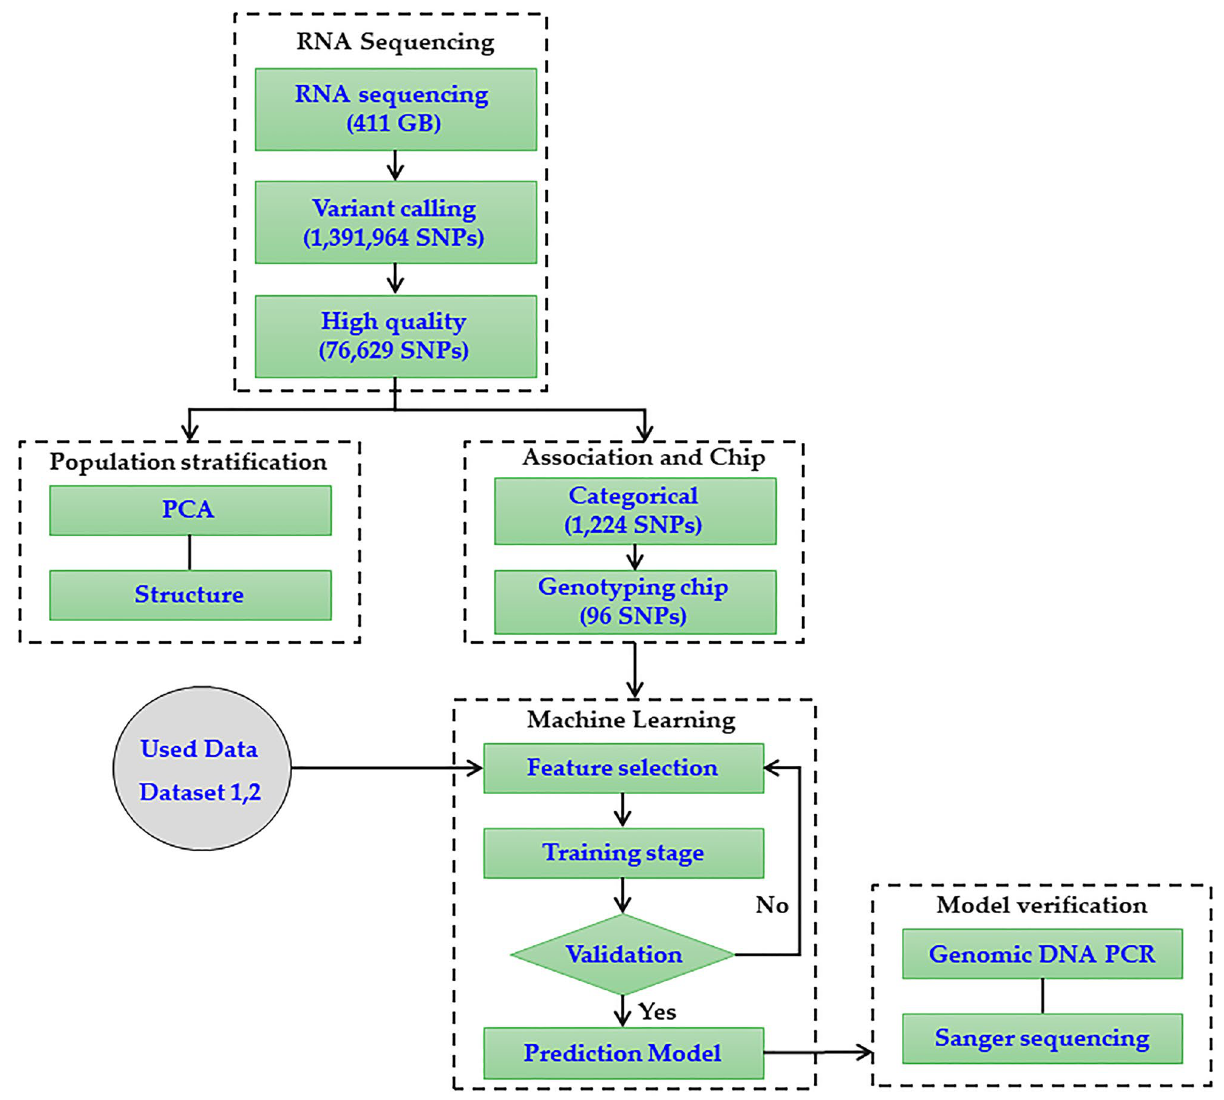
Figure 1. Overview of the SNP analysis pipeline for P. grandiflorus flower color classification using machine learning